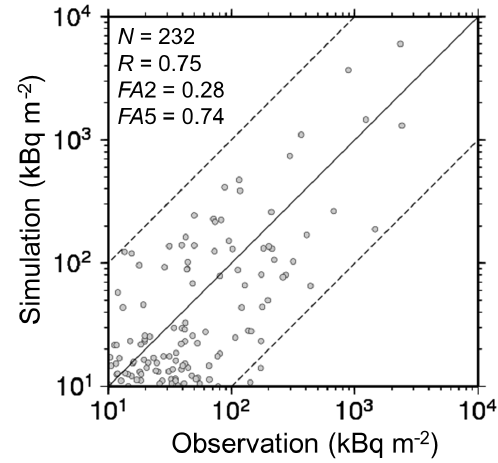
Figure 5. Scatterplot between the observational data and the sim- ulation results for 137 Cs deposition (kBqm − 2 ) . The deposition parameters of the simulation in the figure are E c = 0.04 and v d = 0.1cms − 1 . N indicates the number of samples, and the sta- tistical measures R , FA2, and FA5 are described in Table 2.